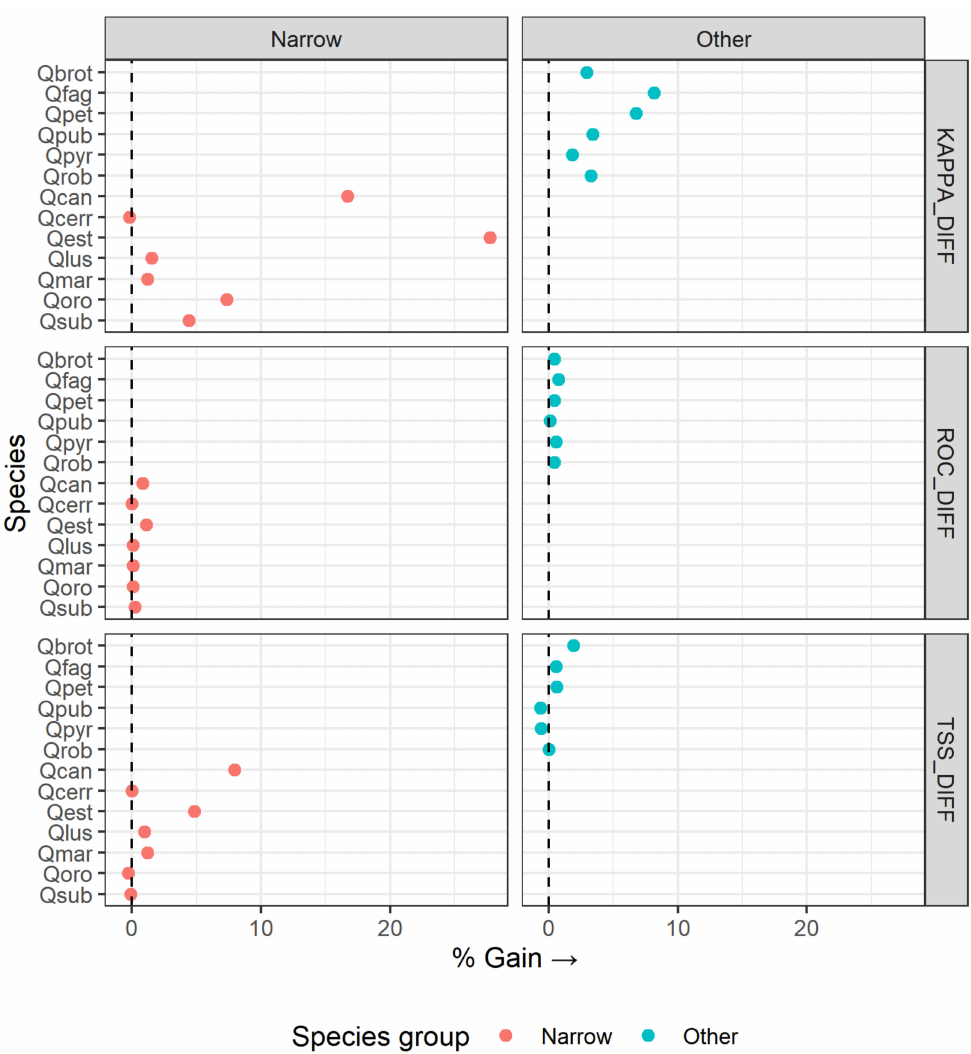
Figure A1. Increased performance of the models (Gains) in NDE (left) and other oaks